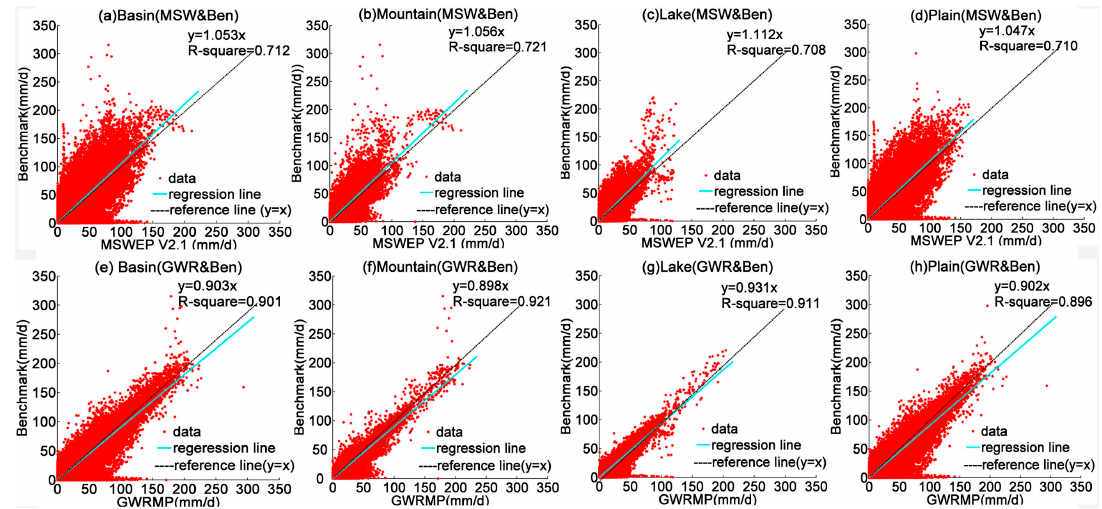
Figure 3. Scatter plot of MSWEP V2.1 and GWRMP corresponding to the benchmark at 0.1 ◦ × 0.1 ◦ grid scale. ( a – d ) are respectively the scatter plot of MSWEP V2.1 and benchmark in the whole basin, mountainous area, lake area and plain area; ( e – h ) are respectively the scatter plot of GWRMP and benchmark in the whole basin, mountainous area, lake area and plain area.